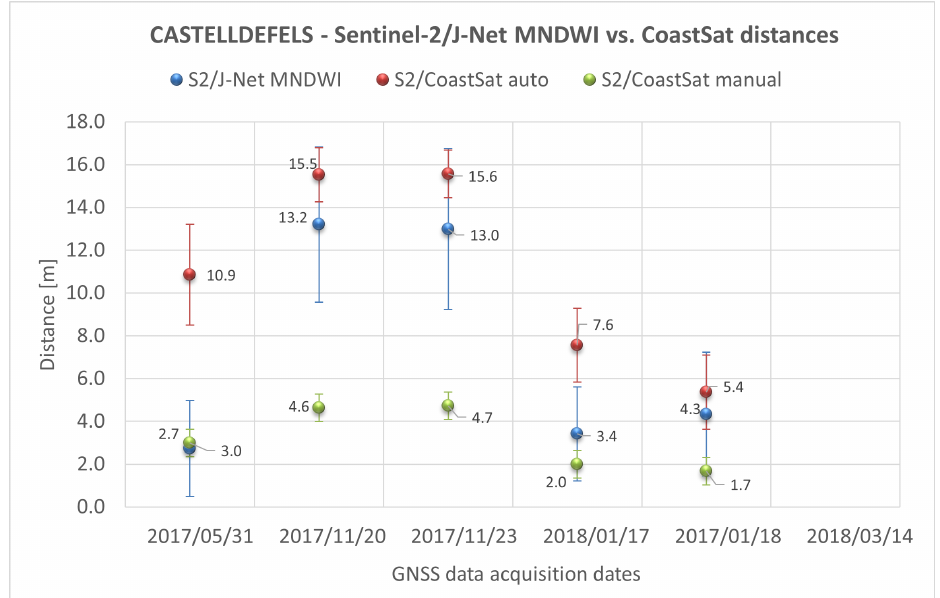
Figure A5. Comparison between the mean distance and standard deviation for each date on Sentinel-2 imagery considering J-Net Dynamic plus MNDWI algorithm and CoastSat with automatic and manual thresholds in